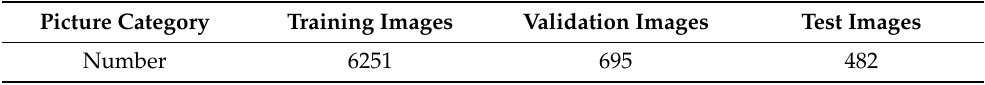
Table 2. Brainwash dataset used in the